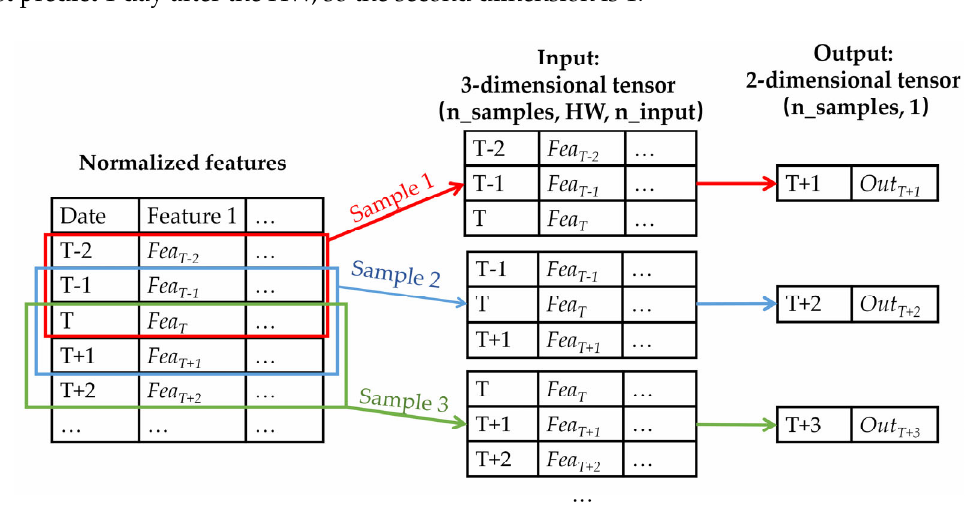
Figure 5. Illustration of format conversion of the input and output features.